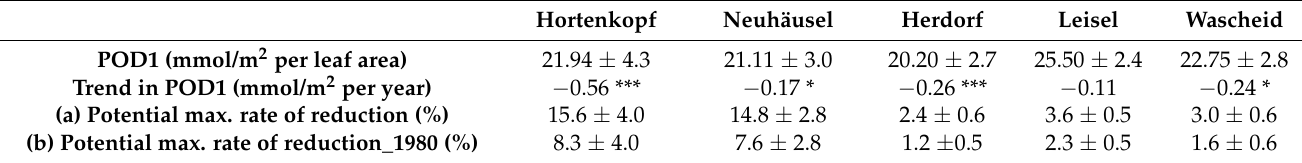
Table 3. Mean values, standard deviations ( ± SD), and annual trends (Mann-Kendall test) of stomatal ozone flux (POD1), maximum potential biomass loss (a) and potential biomass loss in beech and Norway spruce for all sites with the 1980 ozone reference (b) over the time period 1998–2019 (significance level: *** p < 0.001; * 0.01 < p < 0.05).